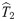
Illustration of the ablation related effects on the prostate, bladder, and rectum modeled by the FEM.((a)) represents the bladder and rectum in pale blue, and prostate in teal. ((b)) represents the synthetic deformation T2. The deformed prostate is shown in yellow, and the arrows in ((b)) represent the direction of the transform (mostly due to the rectum). ((c)) represents the result of the recovered deformation T^2. The deformed prostate is shown in semi-transparent yellow in ((b)) and ((c)). The high level of overlap between the semi-transparent yellow prostate and the teal prostate in ((c)) shows the accuracy of removing the simulated effects of the bladder and rectum motion.